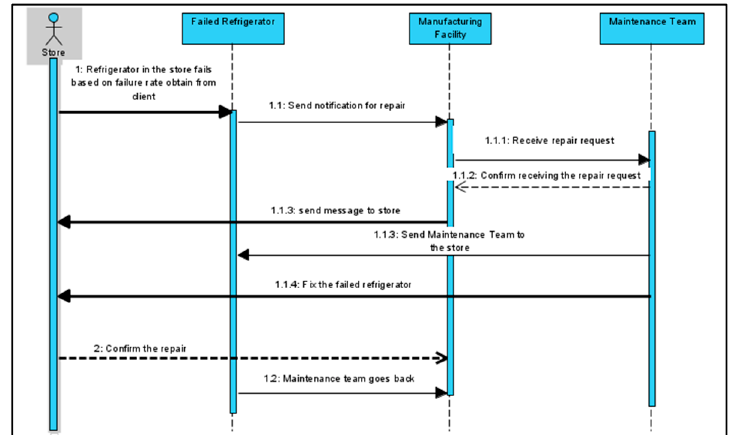
Figure 4. Class diagram.